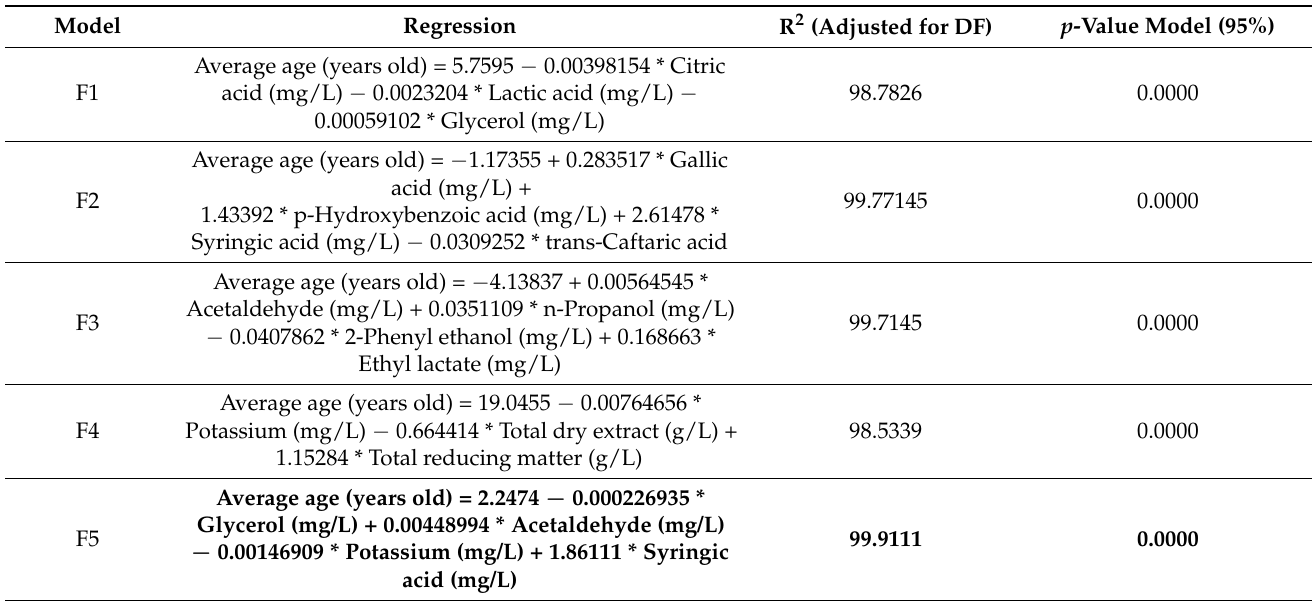
Table 10. Regression models (MLR) to estimate the aging of Fino wines. F1: organic acids and glycerol model; F2: polyphenols model; F3: volatile compounds model; F4: “other variables” model; F5: overall model.